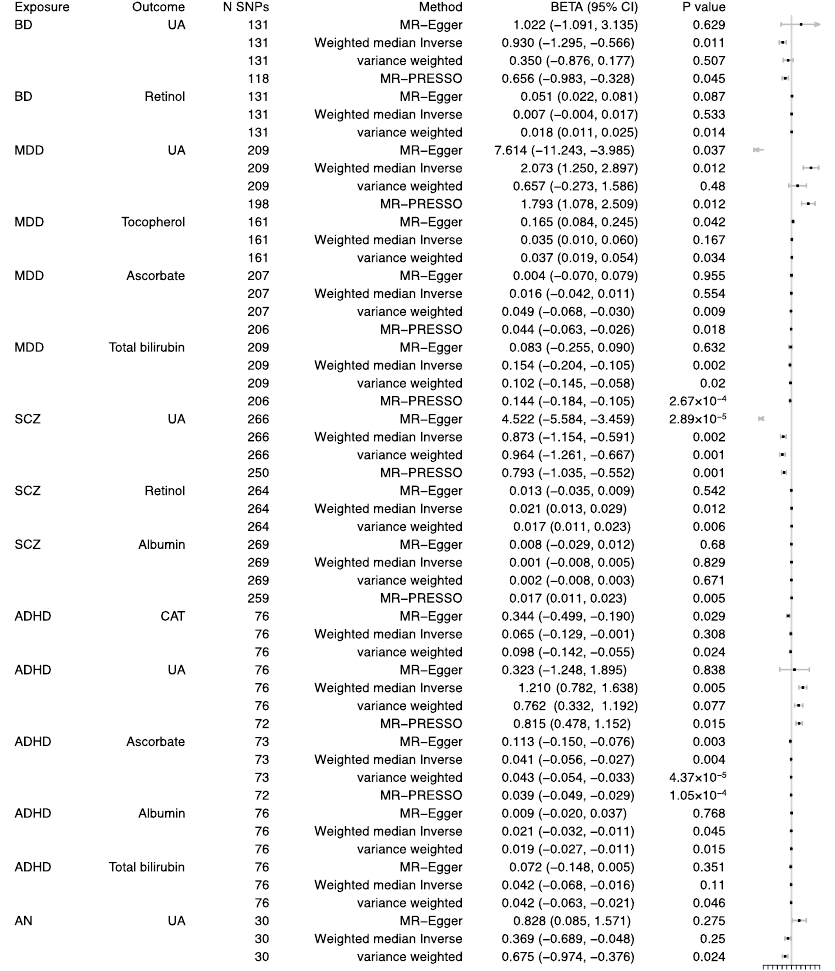
Figure 3. Associations between genetically predicted psychiatric disorders and oxidative stress injury biomarkers. CAT, catalase; UA, uric acid; SCZ, schizophrenia; BD, bipolar disorder; MDD, major depressive disorder; ADHD, attention-deficit/hyperactivity disorder; AN, anorexia nervosa; SNP, single nucleotide polymorphism.